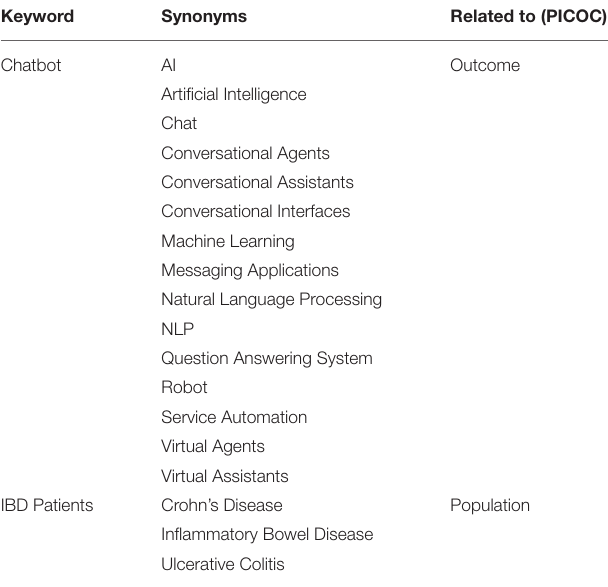
TABLE 1 | Brainstorming of keywords, synonyms, and field. Keyword